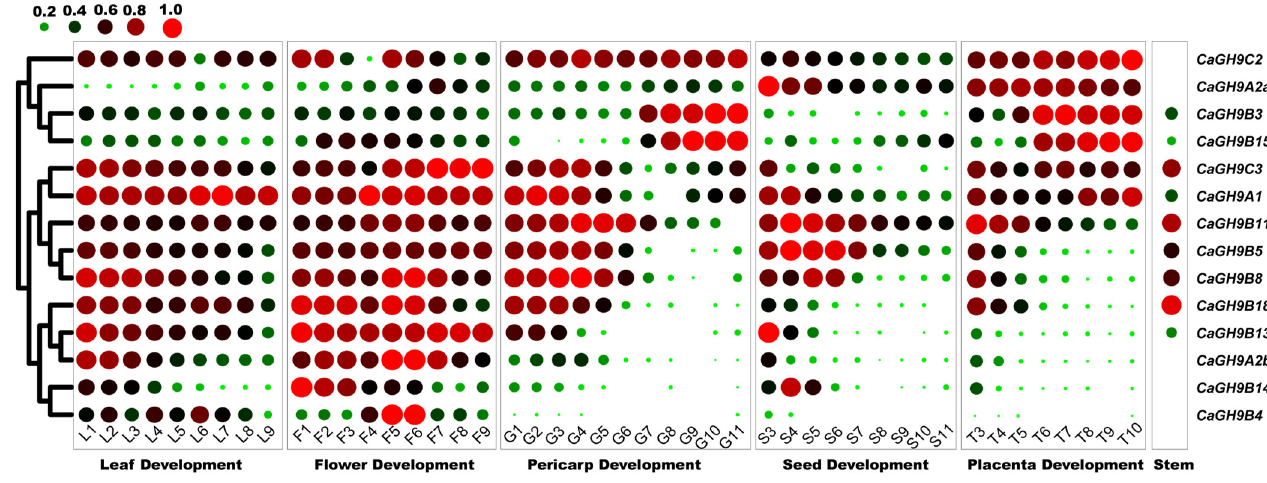
Figure 6. Expression profiles of pepper GH9 family genes in different tissues. Log2 and row scale normalization to 1 were applied to the RNA-seq based reads per kilo base per million mapped reads (RPKM) values to avoid the orders of magnitude difference in gene expression among different GH9 members. RNA-seq data was derived from PepperHub database, and the heatmap visualization was performed using TBtools. The scale (upper left) shows that the expression value gradually increases from small green dot to large red dot. A gene with a 0 RPKM value will have a 0-sized dot.